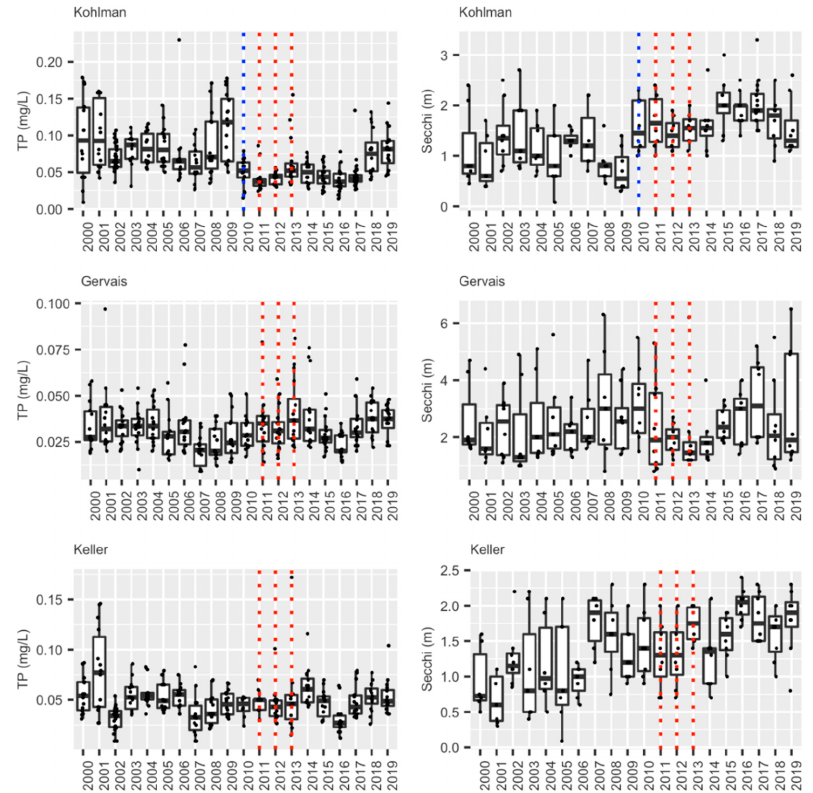
Figure 5. Summer (June–August) epilimnion water quality values (TP, or Total Phosphorous, and Secchi Depth (clarity in m)) for lakes Kohlman, Gervais and Keller. The blue dotted line shows when the alum treatment occurred [35] while the dotted red lines show years of carp removal in the Kohlman- Gervais-Keller system of lakes (see